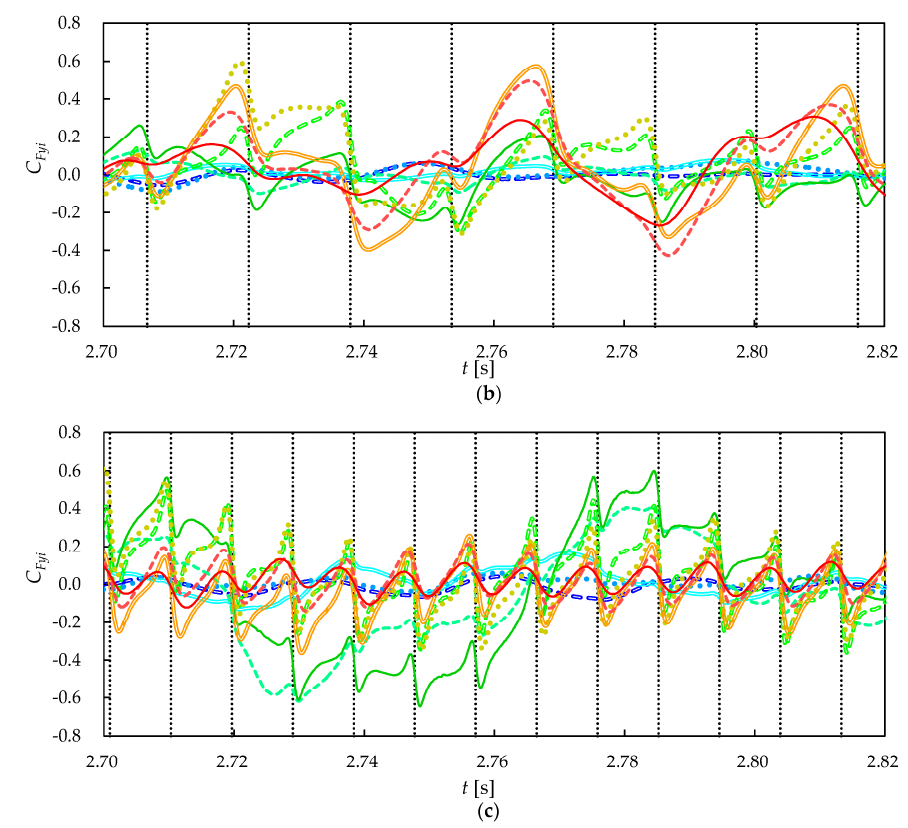
Figure 16. Time history of the instantaneous lift coefficient of each tower segment. The vertical dotted lines indicate the time at which the blade nearest the tower is at Ψ = 0°. ( a ) λ = 3; ( b ) λ = 6; and ( c ) λ = 10.